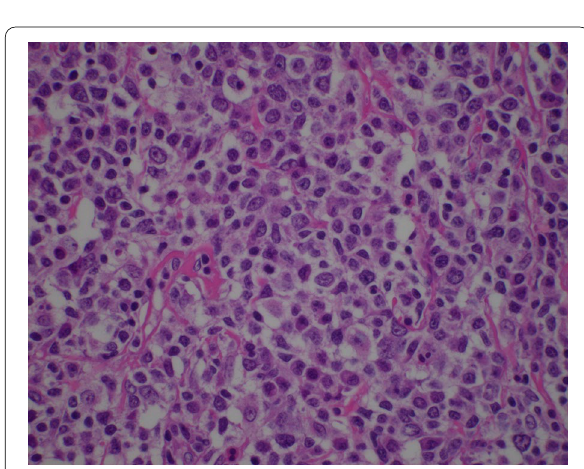
Fig. 4 Hematoxylin and eosin staining of appendiceal tumor ( magnification)